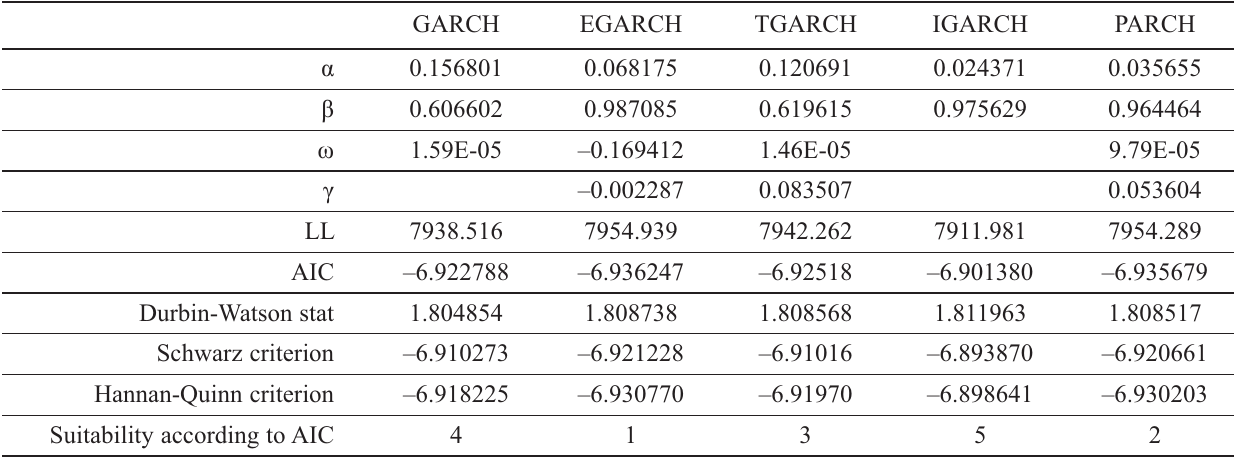
Table 2. Suitability of “GETIP” models for OMXV